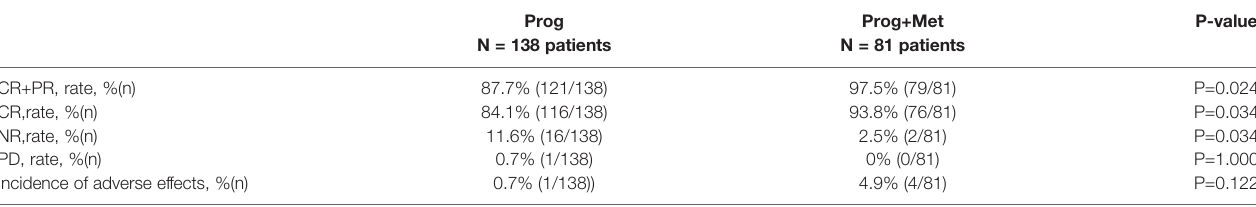
TABLE 2 | Comparison of treatment responses between the Prog group and the Prog+Met group. Prog